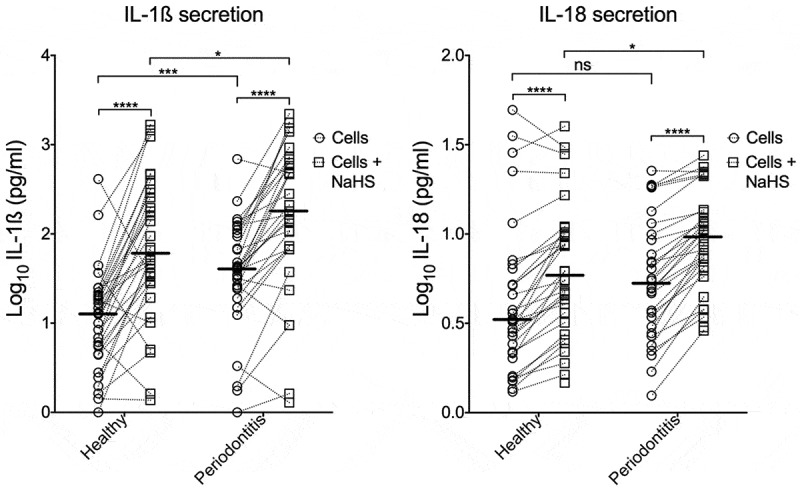
Cytokine secretion of PBMCs.The secretion of IL-1β and IL-18 from both unexposed PBMCs and exposed PBMCs to H2S. The PBMCs were sampled from patients with periodontitis and from healthy controls. The median is shown as a vertical line (IL-1β: 1.10 and 1.78 for healthy sites, 1.61 and 2.25 for periodontitis sites. IL-18: 0.52 and 0.77 for the healthy, 0.72 and 0.98 for periodontitis sites).